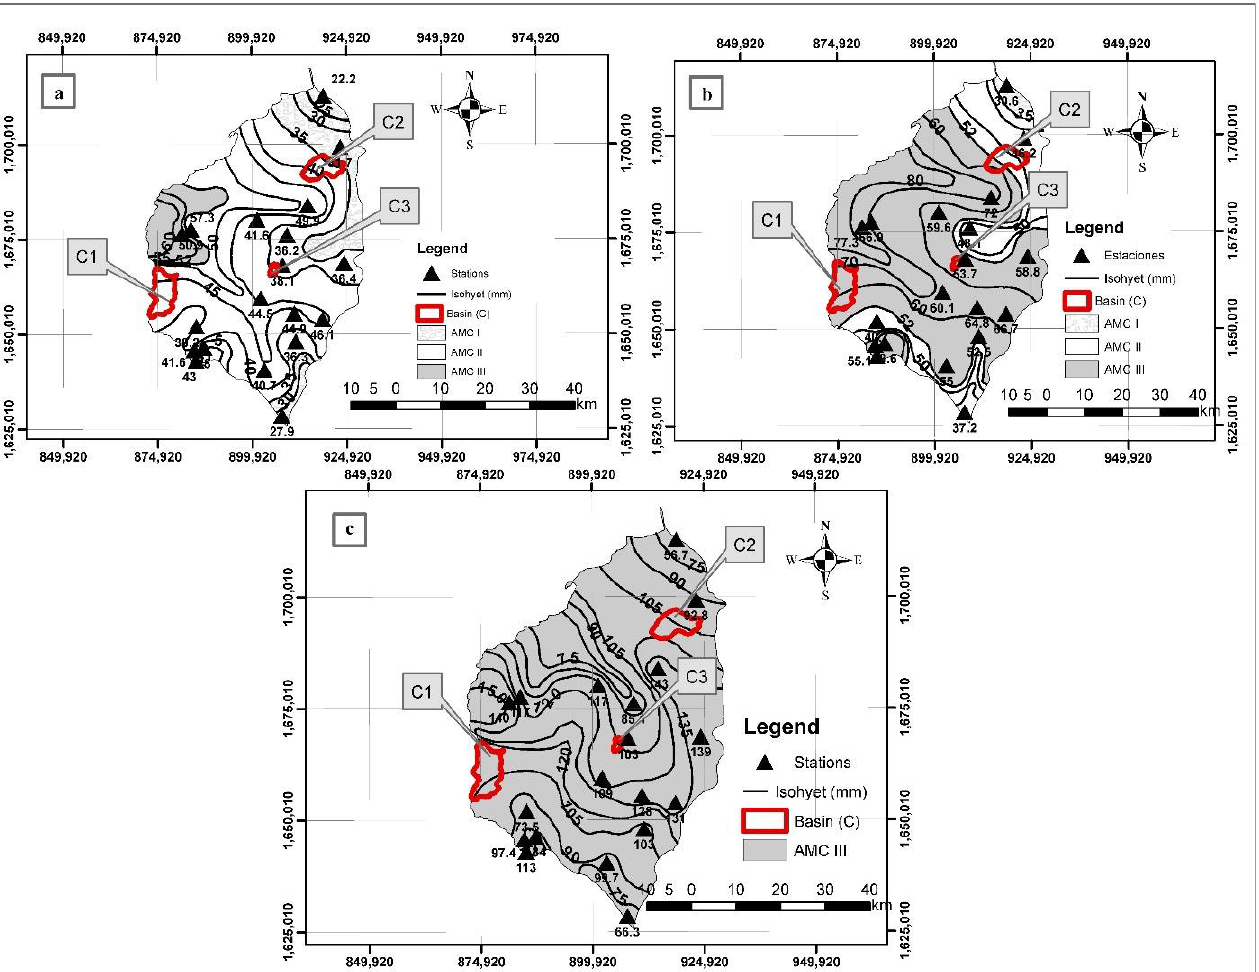
Figure 11. Spatial distribution of P prior-5d of the antecedent moisture content for basin C1, C2 and C3. Spatial distribution of the type of moisture in the basins considering: ( a ) a return period of 5 years; ( b ) a 10-year RP; ( c ) 100-year RP.